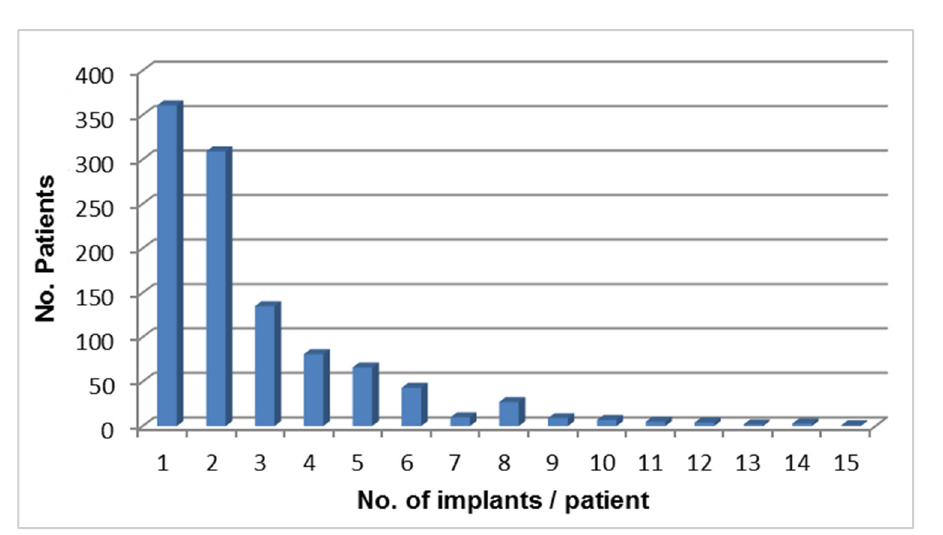
Figure 1. Number of